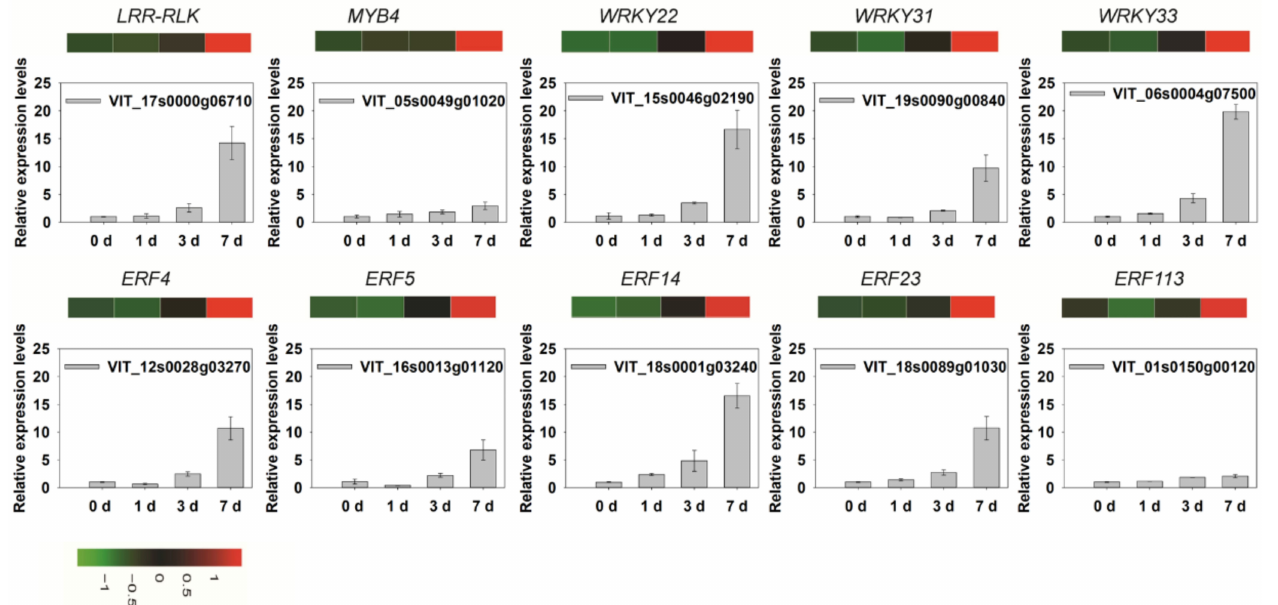
Figure 8. Validation and expression analysis of 10 genes in response to Colletotrichum viniferum . Gene expression analysis was carried out with qRT-PCR using cDNA from berries of Vitis davidii Föex after Colletotrichum viniferum inoculation for different lengths of time. Color panels above the bars symbolize log2-transformed mean expression values obtained in the RNA-seq (see reference color bar). All data are shown as the mean ± SD ( n =